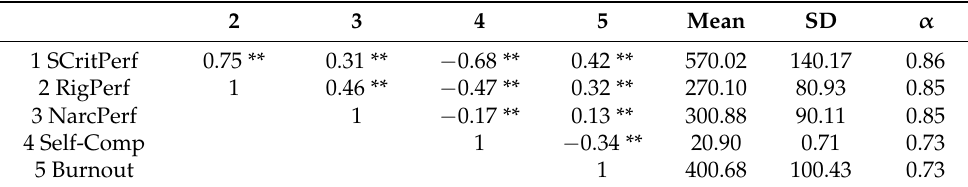
Table 1. Descriptive statistics, internal consistencies, and